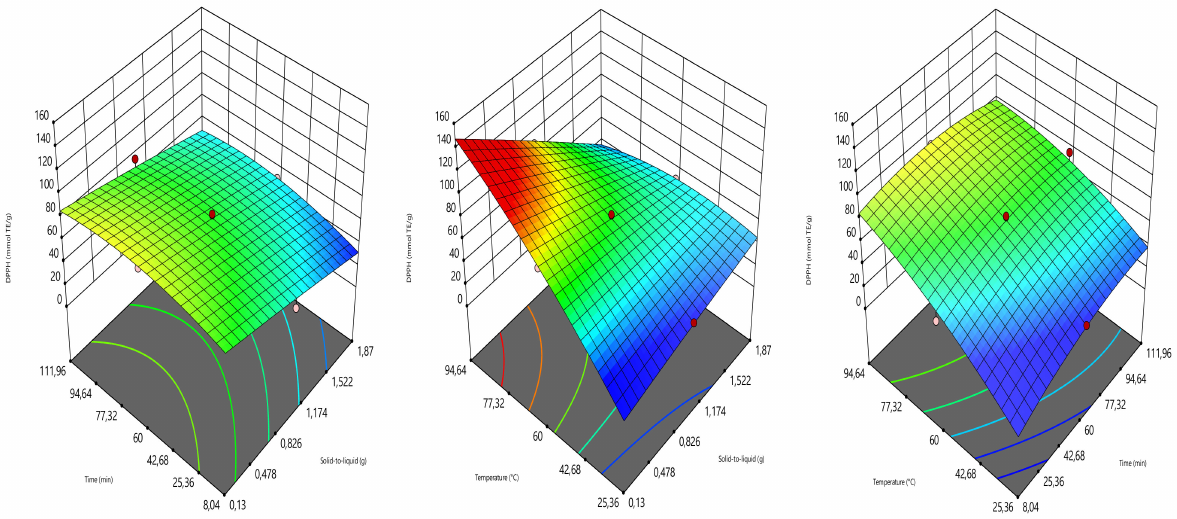
Figure 4. Three-dimensional graphics showing the effects of the independent variables on DPPH.